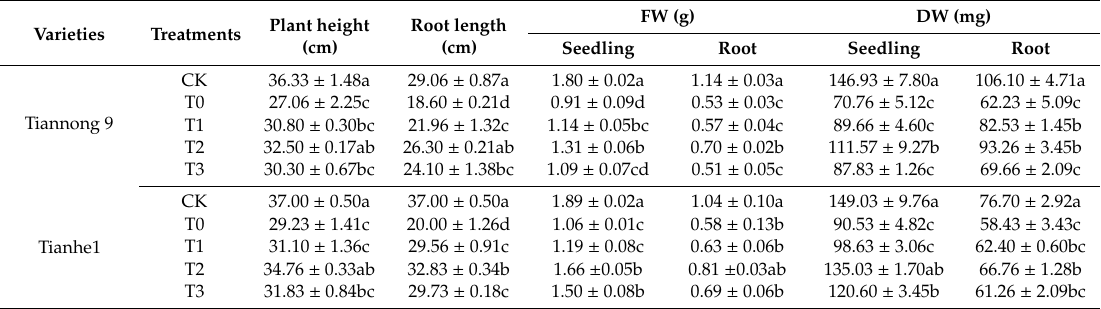
Table 1. The e ff ects of di ff erent concentrations of BL on plant height, root length, shoot and root weight of maize seedlings under chilling